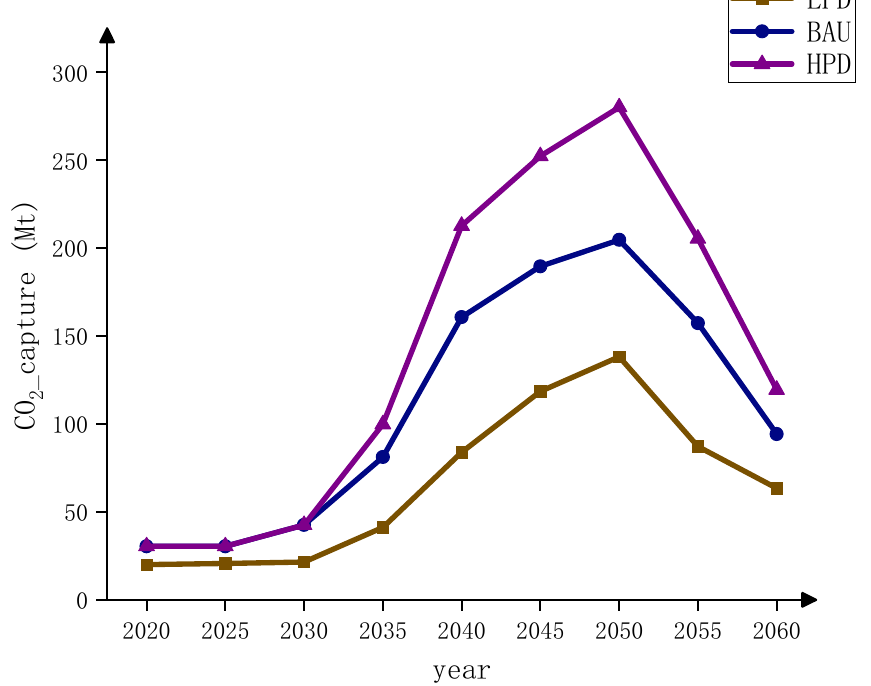
Figure 5. The CCUS CO 2 capture under different scenarios in the Northeast grid region between Figure 5. The CCUS 𝐶𝑂 (cid:2870) capture under different scenarios in the Northeast grid region between 2020 and 2020 and 2060.